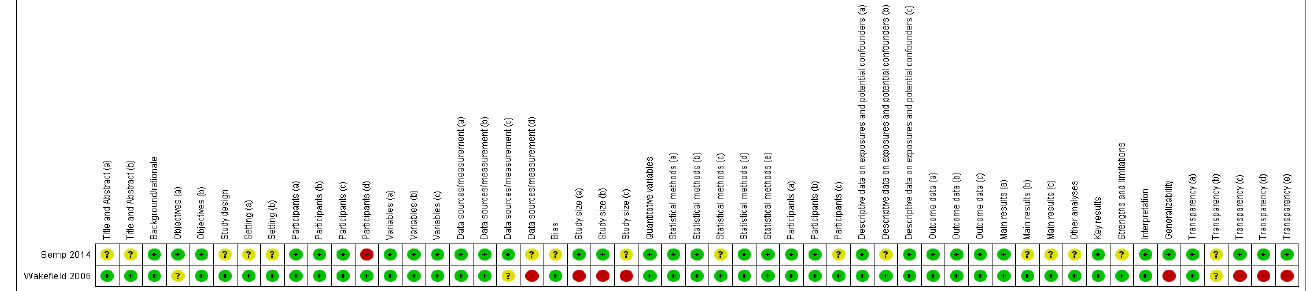
Figure 5. Reporting guidelines summary: review authors’ judgements about each criterion pre- sented as percentage across all included studies.